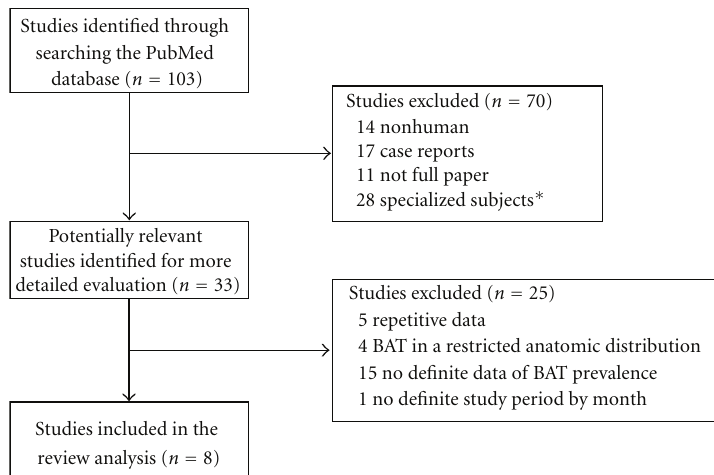
Figure 2: The flow chart for the inclusion and exclusion of studies for the current review analysis ( ∗ 8 on pediatric patients, 2 on only men or women, 8 on patients with a specific disease, 10 on premedication or temperature control to influence BAT